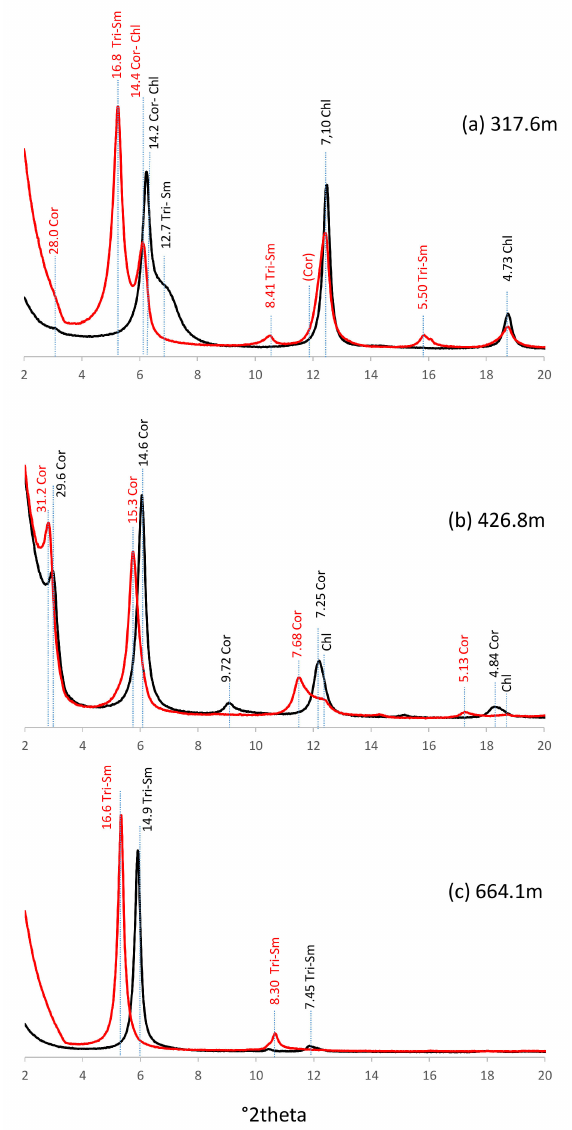
Figure 5. X-ray diffractograms of oriented preparations: infra 2 µ m clay fraction. In black: air dried; and in red: ethylene glycol-solvated preparation. Tri-Sm: tri-smectite, Cor: corrensite, and Chl: